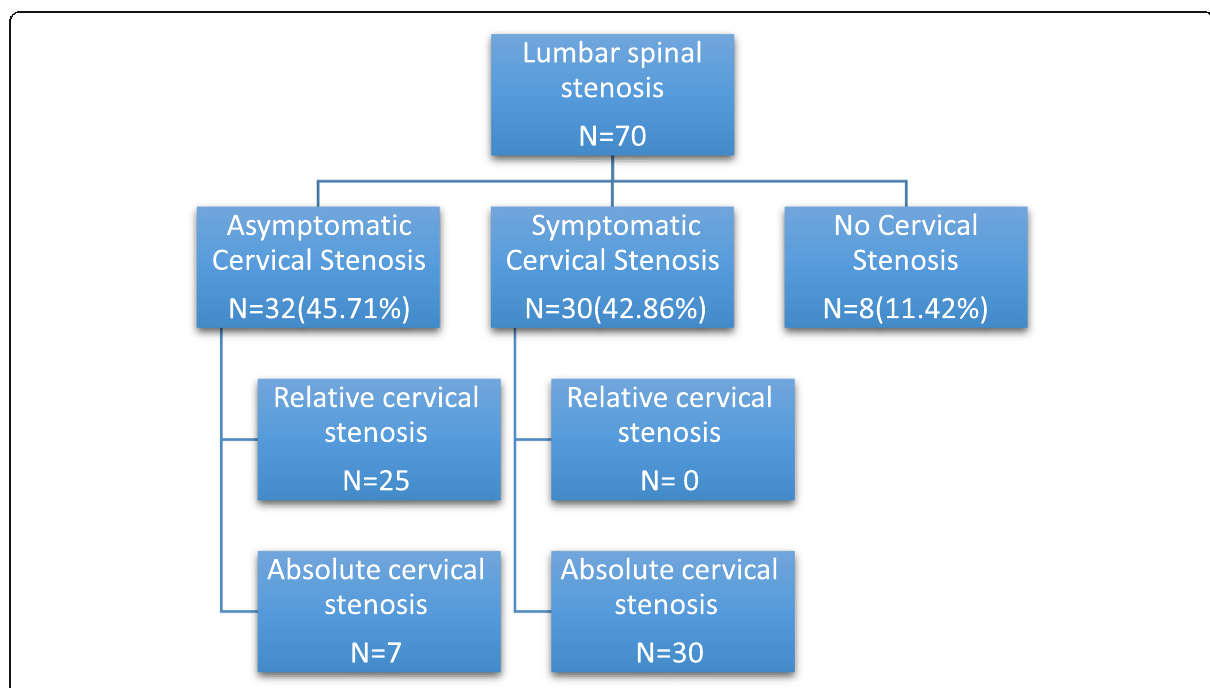
Fig. 1 Flow chart of cervical stenosis diagnoses among lumbar patients